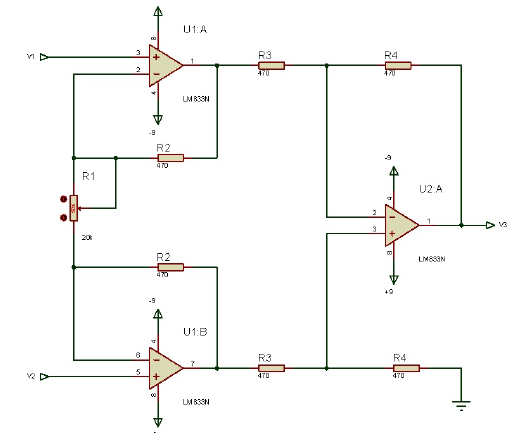
Figure 4. Schematic of the amplifier circuit with